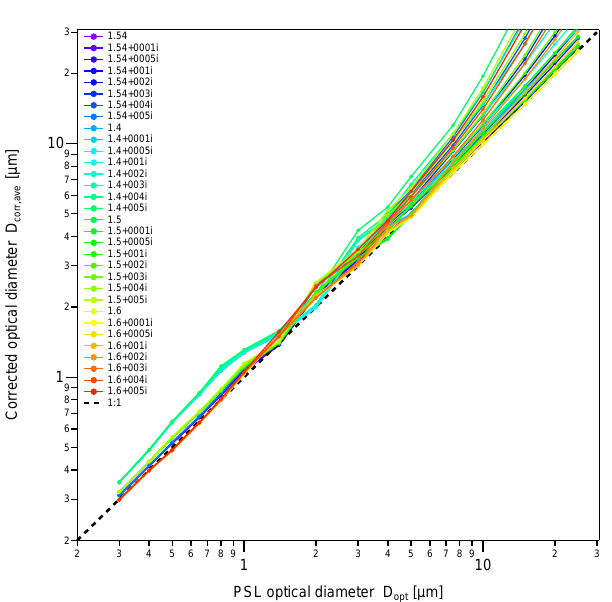
Fig. A3. Diameter correction curves for the deployed Grimm 1.108 OPC for a selected matrix of complex refractive indices.